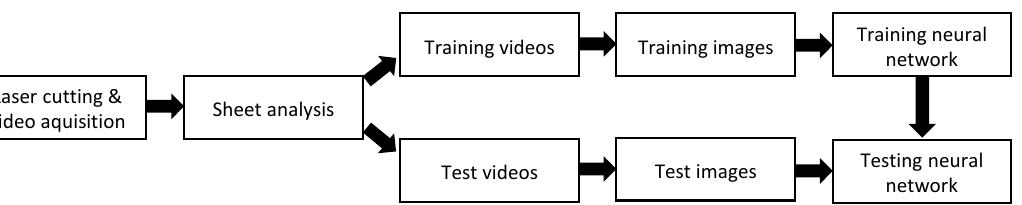
Figure 5. Workflow diagram. Figure 5. Workflow